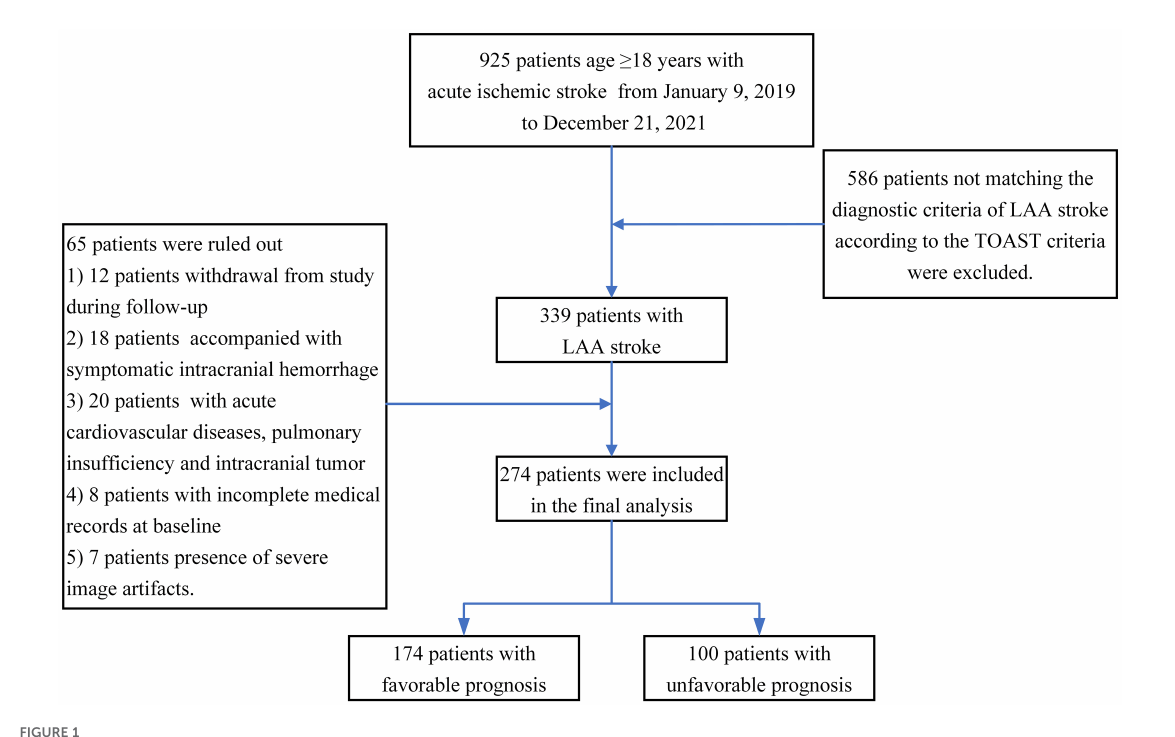
FIGURE1 Schematic of the screening